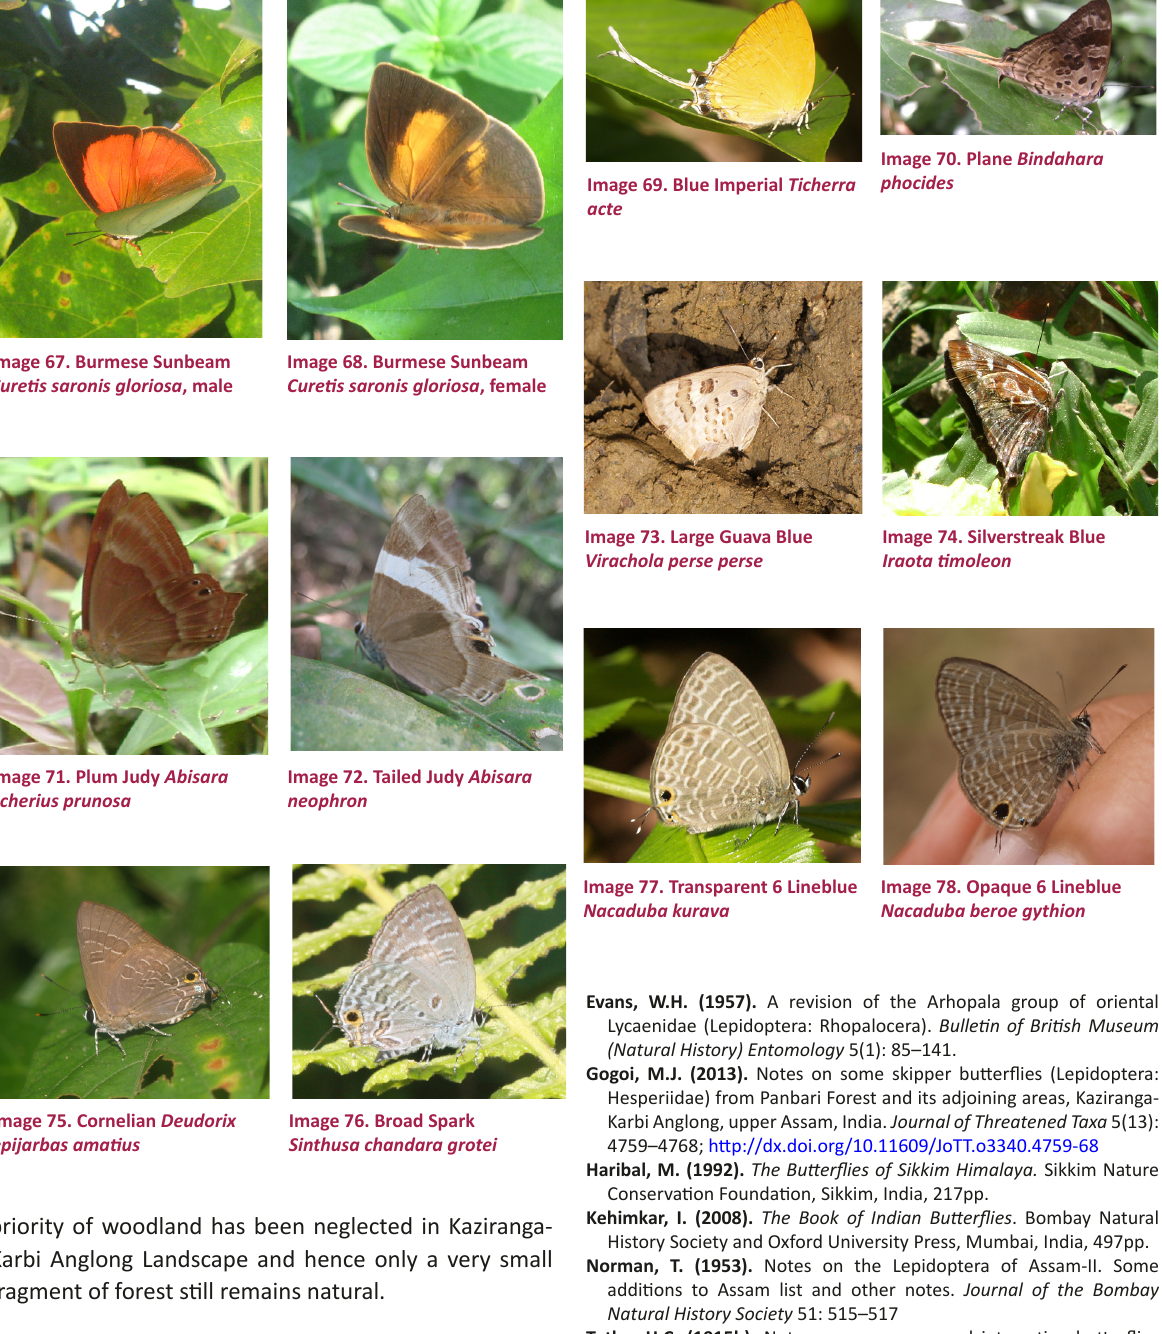
Image 75. Cornelian Deudorix epijarbas amatius